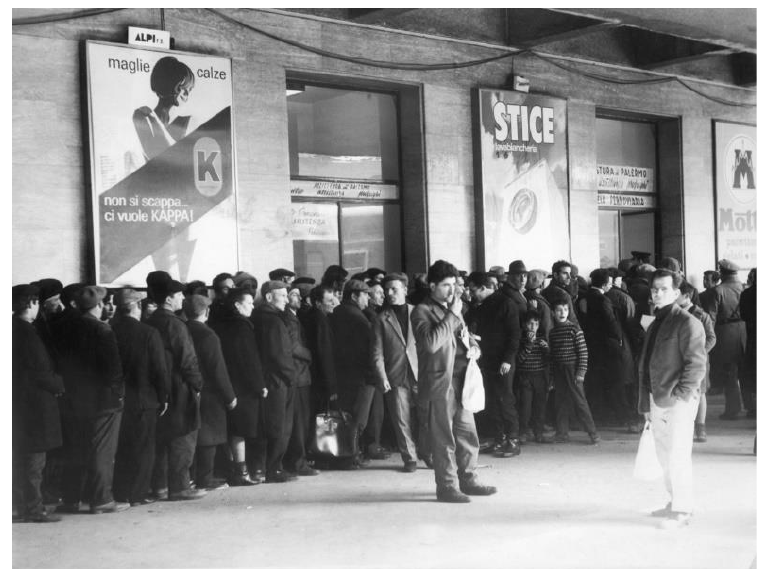
Figure 8. Refugee departures from Palermo station, 27 January 1968. Photo: Archivio de L’Ora, Biblioteca Regionale Siciliana “Alberto Bombace”, Palermo.